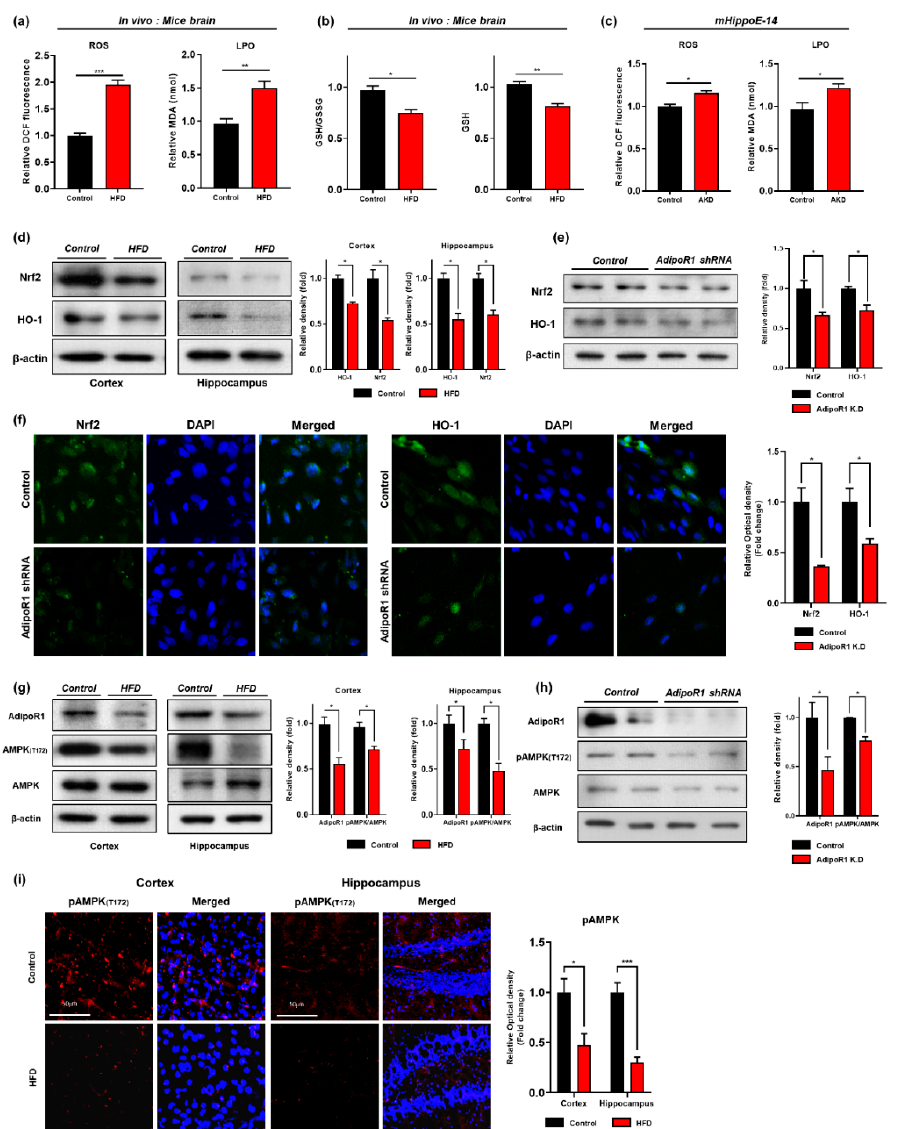
Figure 2. HFD induced Oxidative Stress impaired AdipoR1 signaling pathway in both in vivo and in vitro ( a ) Representative histogram of reactive oxygen species (ROS) and lipid peroxidation (LPO) levels (assay carried out in triplicates) ( b ) and glutathione (GSH; in reduced state) levels (nmol / mg protein) along with GSH / GSSG ratio (GSSG; glutathione in oxidized state) of normal chow and high fed diet mice brains (n = 12 mice / group) ( c ) The histogram showing the results of reactive oxygen species (ROS) and lipid peroxidation (LPO) levels in control and AdipoR1 knockdown in the embryonic mouse hippocampal cell line mHippoE-14 (adipoR1 shRNA) ( d , e ) Shows the western blot analysis of nuclear factor-2 erythroid-2 (Nrf-2) and hemeoxygenase-1 (HO-1) along with respective histograms in HFD-fed mice brains and AdipoR1 knockdown embryonic mouse hippocampal cell line mHippoE-14(adipoR1 shRNA) ( f ) Immunofluorescence staining images of Nrf-2 and HO-1 in the control and AdipoR1 knockdown embryonic mouse hippocampal cell line mHippoE-14(adipoR1 shRNA) ( g , h ) Shows the western blot analysis of AdipoR1 and its downstream p-AMPK (T172) and total AMPK in both in vivo and in vitro ( i ) Immunofluorescence imaging of phosphorylated AMPK in the cortex and hippocampus region of control and HFD mice brain along with their histograms. β -Actin was used as loading control; n = 12 mice / group. Data are presented as mean ± SEM. Data for immunofluorescence and western experiment are compared using Student t -test and other data are compared using one-way ANOVAs. Significance = * p < 0.05, ** p < 0.01, *** p <